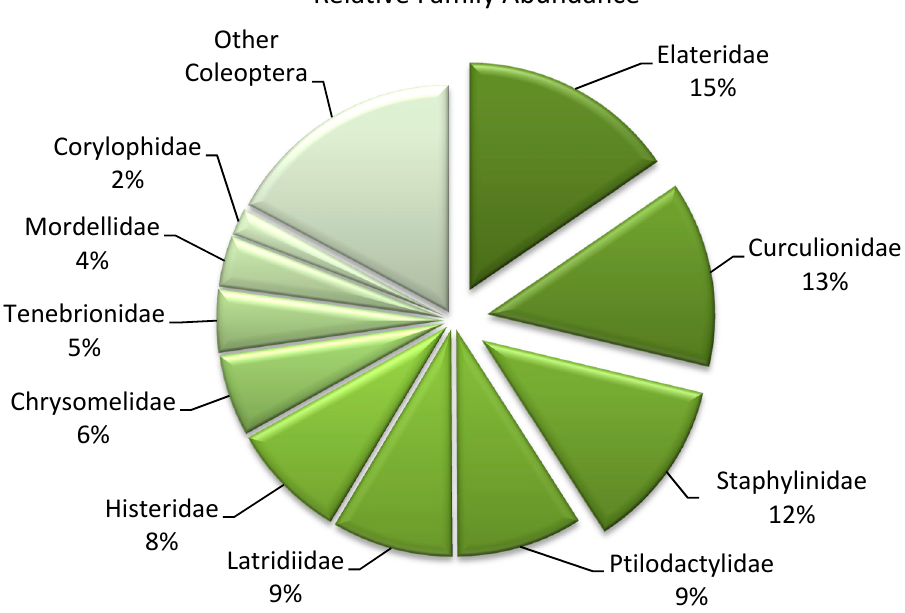
Figure 1. Relative abundance of the 10 numerically dominant coleopteran families found in forests associated with emerald ash borer-induced ash mortality.